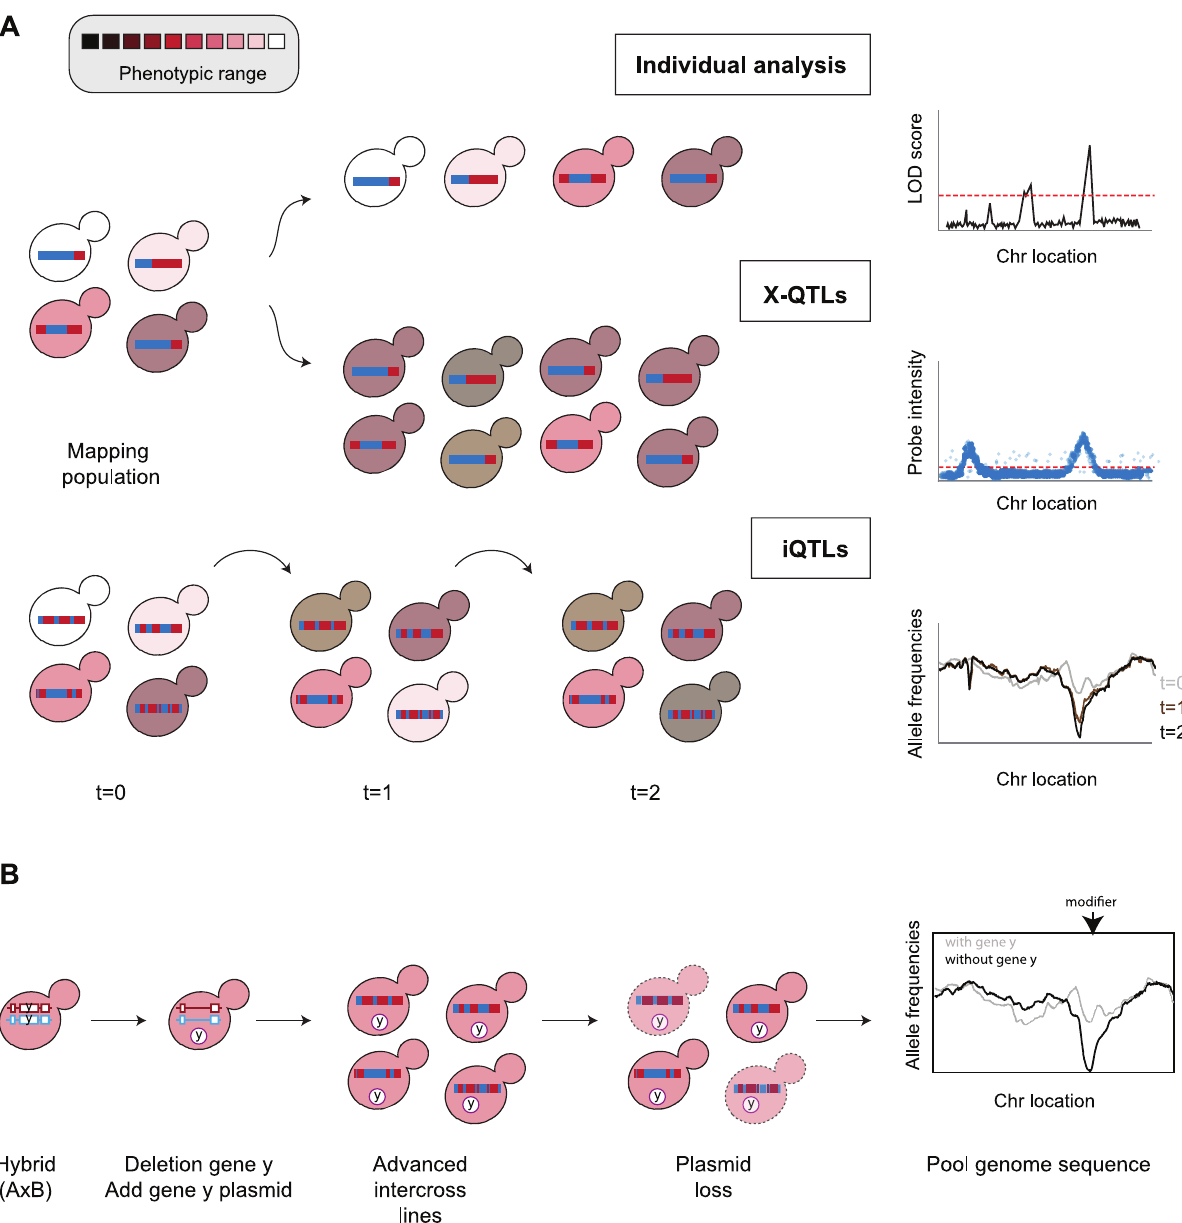
Figure 2. Mapping QTLs and modifiers. (A) QTL mapping has evolved from the classical approach of individual segregant analysis to the X-QTLs and iQTLs approaches with higher mapping sensitivity and resolution. Analysis of time series data in iQTLs allows dynamic monitoring of allele frequency values [56]. (B) A possible approach to map genetic modifiers using iQTLs. A conditional essential gene, y , is deleted from its original chromosomal location and maintained on a plasmid. This hybrid is intercrossed multiple times to allow reshuffling of parental genomes. Upon loss of gene y , viability relies on the presence of genetic modifier/s, and allelic combinations that result in lethality (dashed cells) will decrease in allele frequency. These modifiers can be detected by comparing allele frequencies of the pool before and after the plasmid loss. When many modifiers are involved, the lethal combinations will be present in low frequency, making them difficult to detect. Further rounds of intercrosses, after loss of gene y , will allow reshuffling of alleles and the generation of more cells with unviable